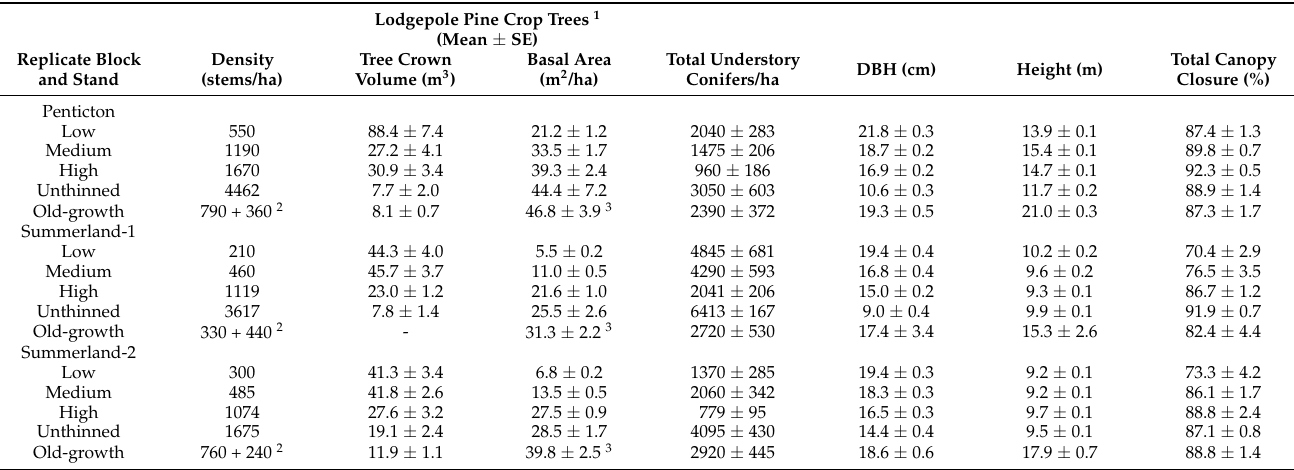
Table 1. Experimental design and characteristics for crop trees in the three replicate blocks of lodgepole pine stands in 2013 at 20–25 years after pre-commercial thinning at Penticton and